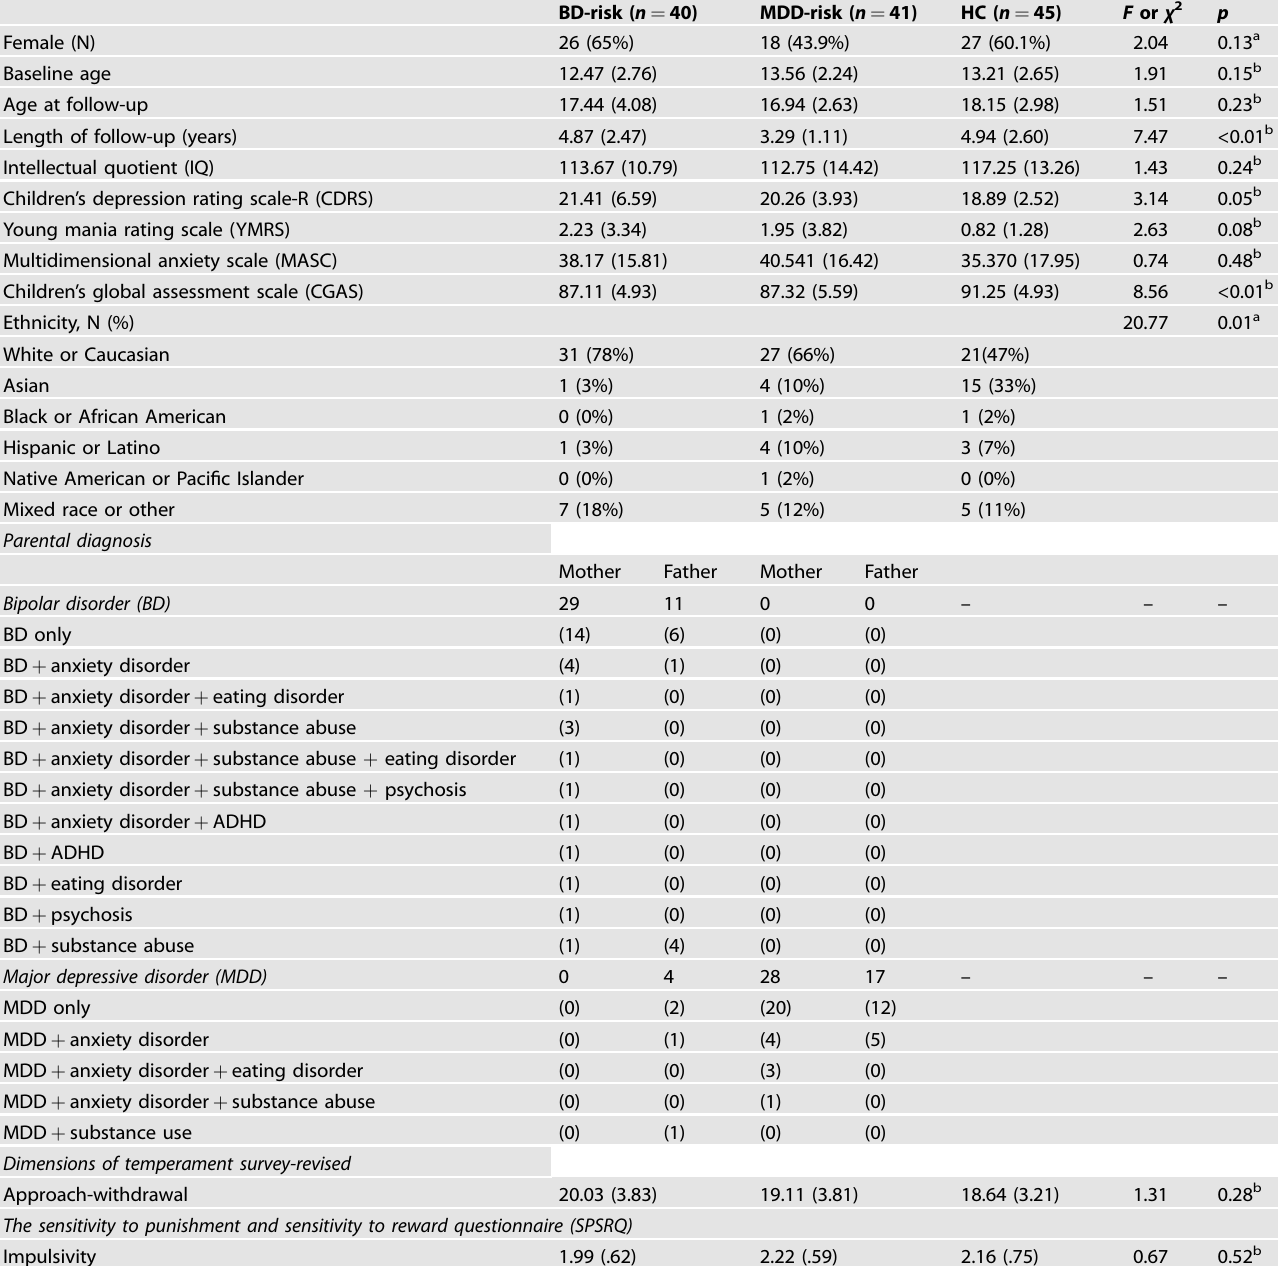
Table 1. Participant characteristics at